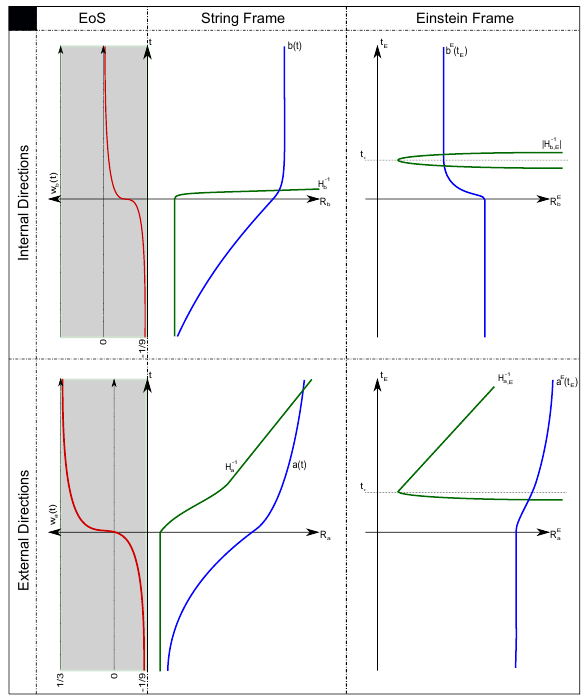
Figure 1 . Sketch of the equations of state and Hubble radii in the string and Einstein frames as a function of time (vertical axis), for both internal and external directions. Stage 1 lasts until the origin of the time axis. The time t (cid:3) corresponds to the end of Stage 3 when the dilaton stabilizes. Most of the time interval between t = 0 and t = t (cid:3) corresponds to Stage